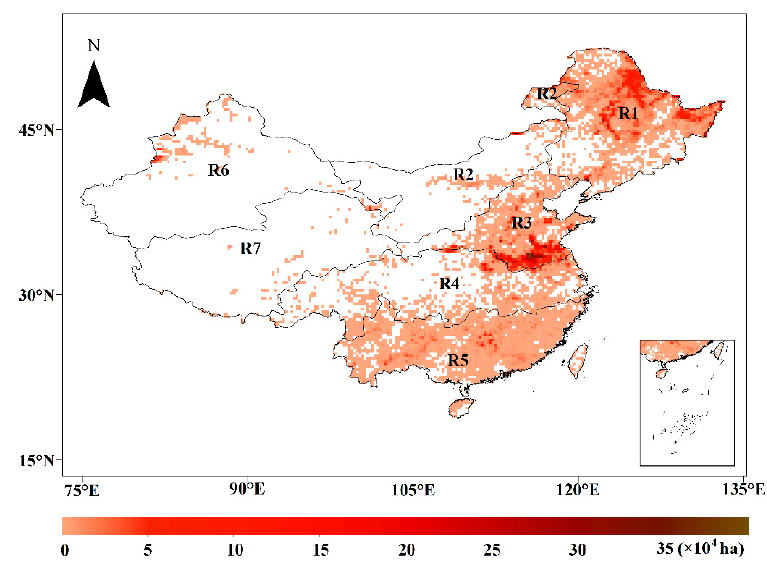
Figure 2. Spatial distribution of accumulated burned area (BA) at the annual scale in China.